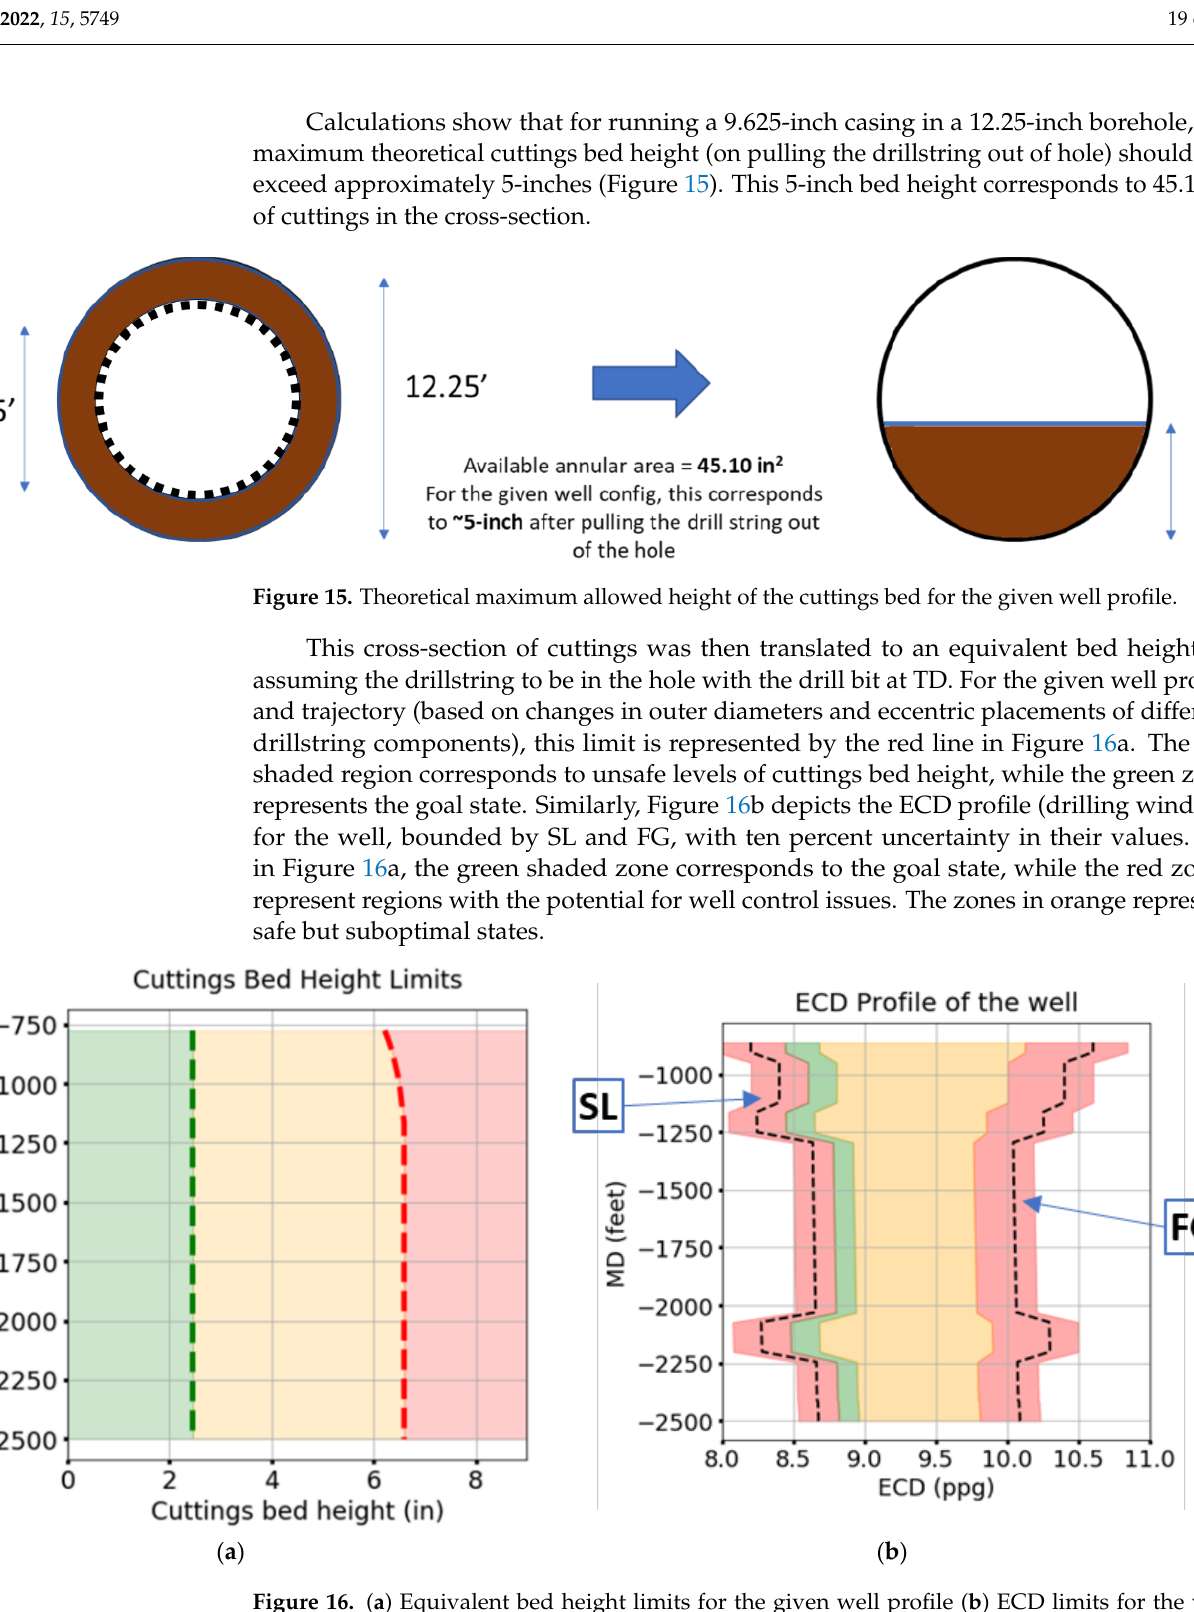
Table 1. The SL and FG values for the different inclination intervals.